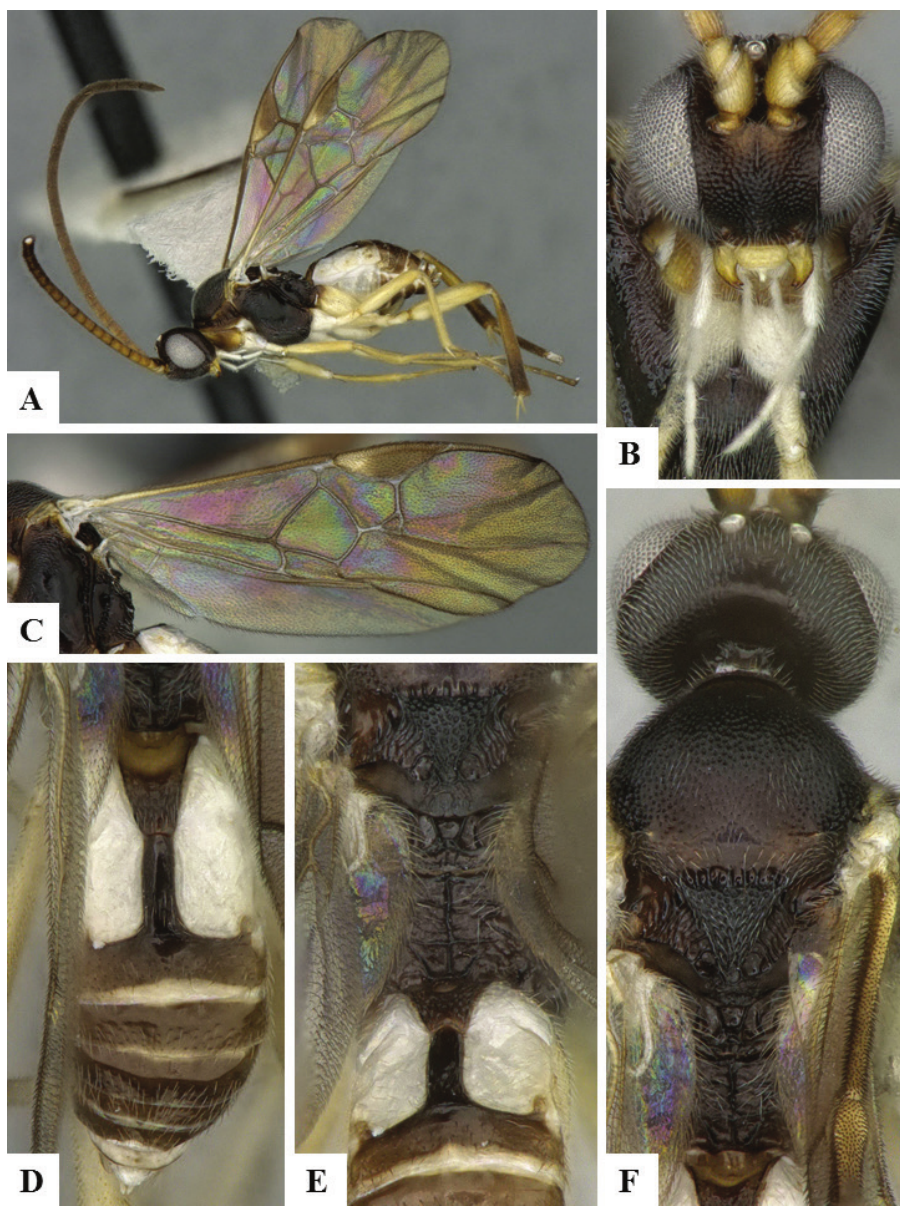
Figure 46. Zachterbergius tenuitergum male holotype. A Habitus B Head frontal C Fore wing D Metasoma dorsal E Propodeum F Head and mesosoma, dorsal. Distribution.